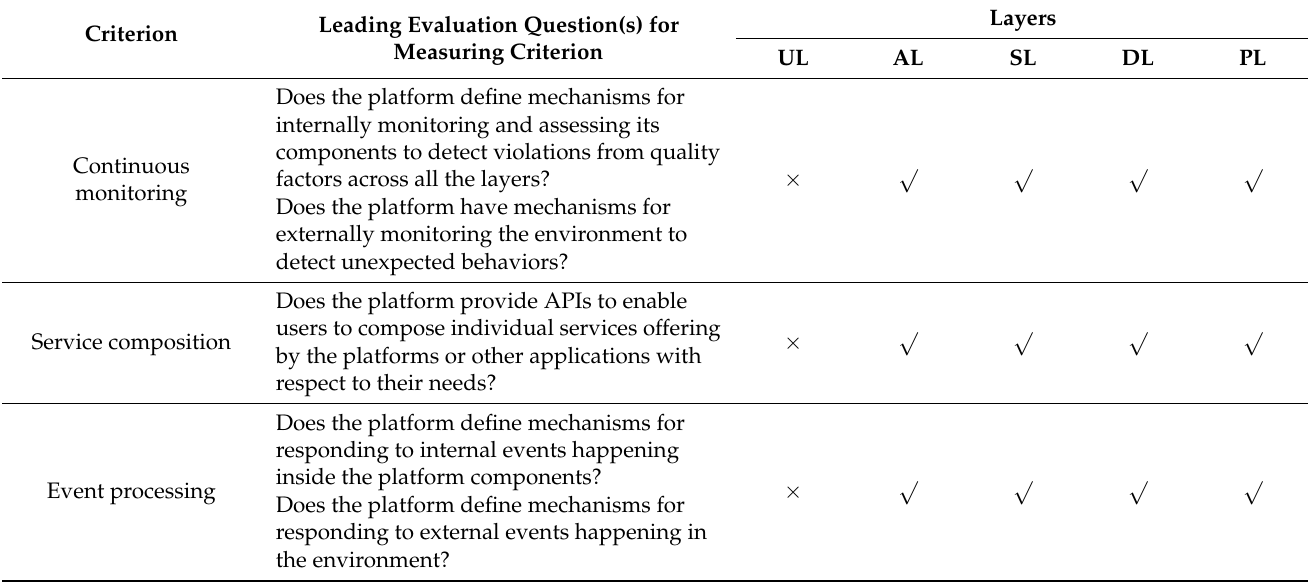
√ : related, × : Not related).